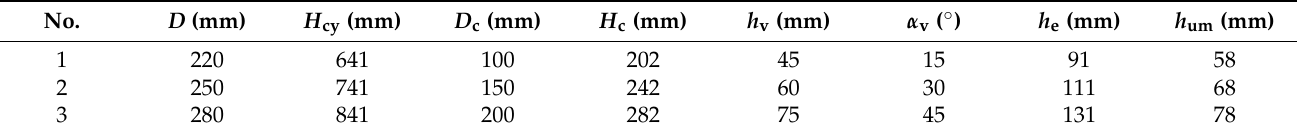
Table 4. Levels of the